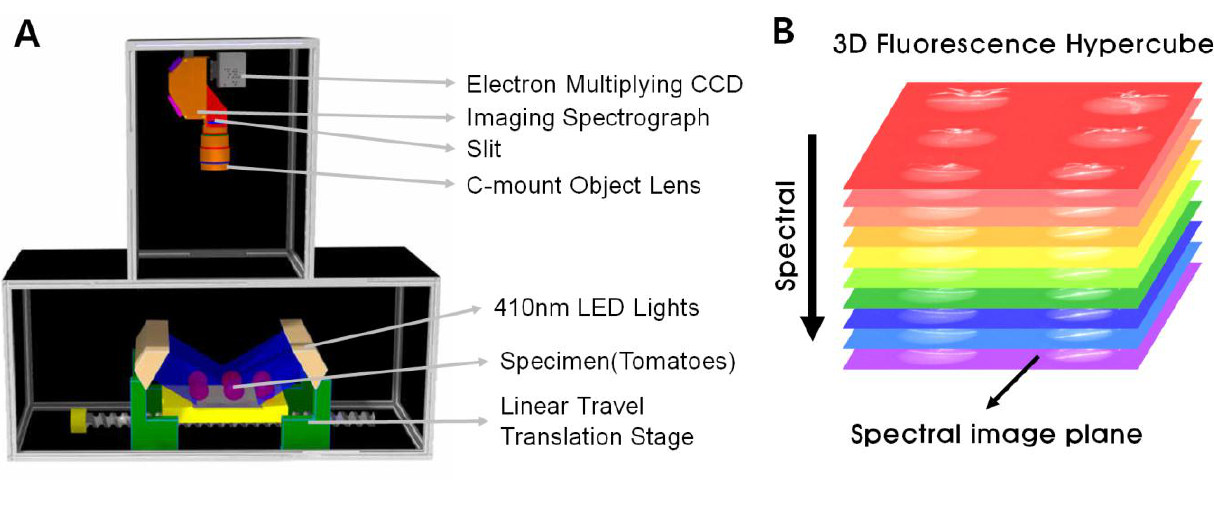
Figure 2. Schematic of the hyperspectral imaging system ( A ) and a structure of the 3D Hypercube ( B